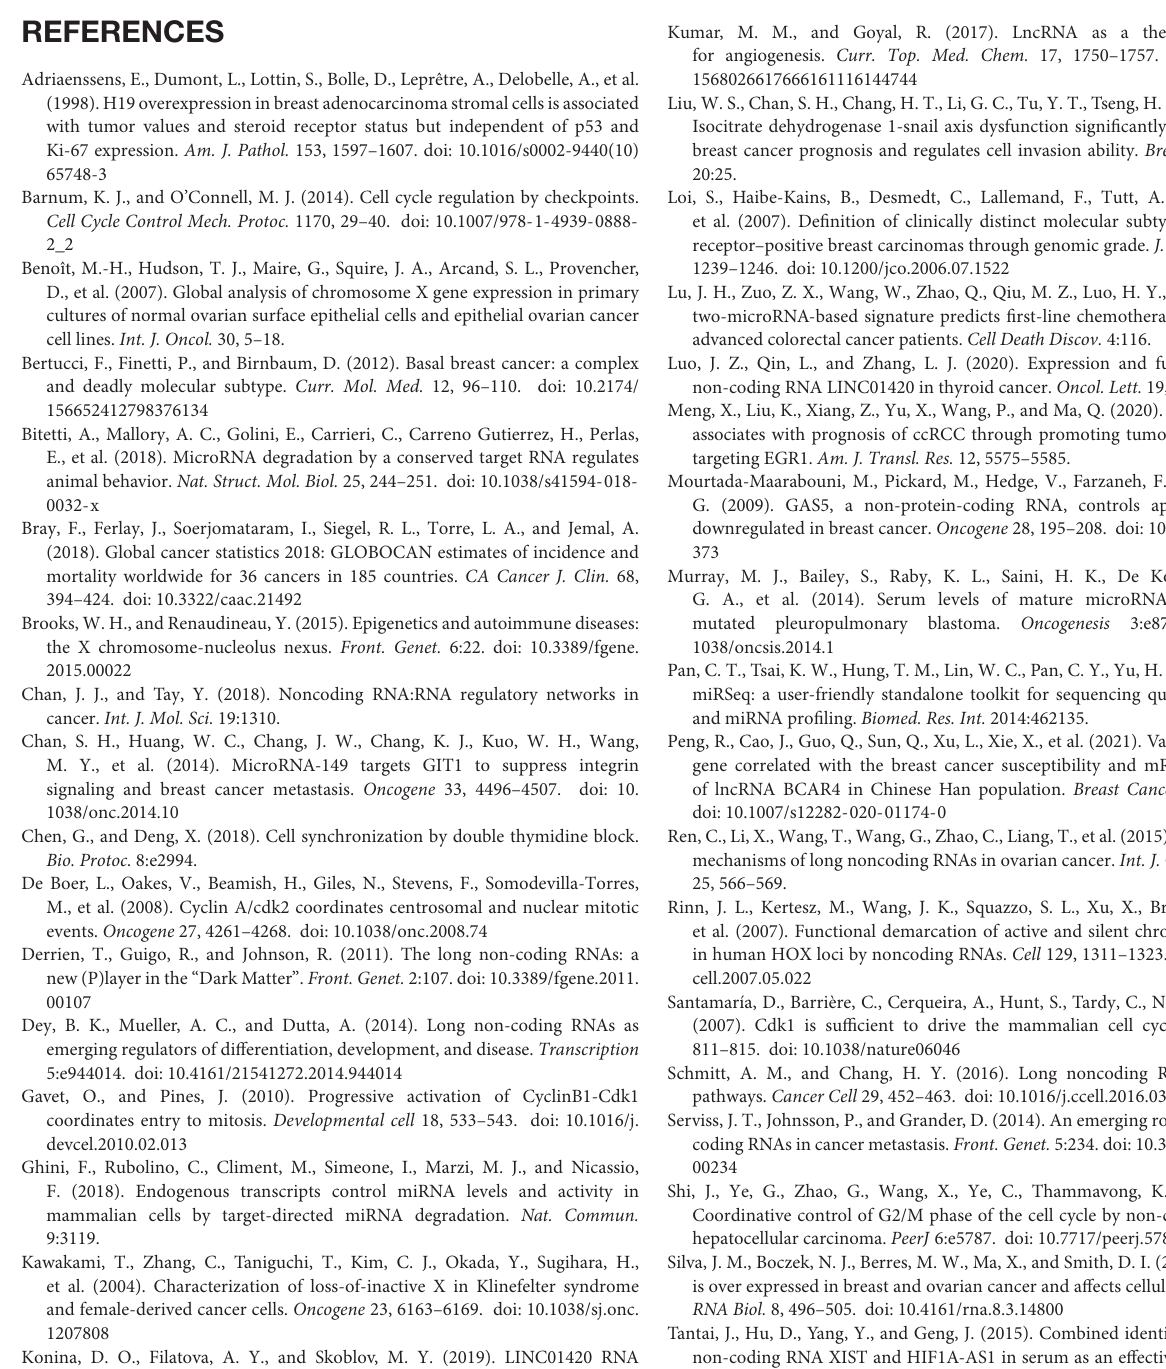
Supplementary Figure 5 | Expression levels of miRNA candidates assessed in human breast cancer cells from TCGA database. The expression levels of (A) miR-29b-5p, (B) miR-34b-3p, (C) miR-125b-2-3p, and (D) miR-629-3p were